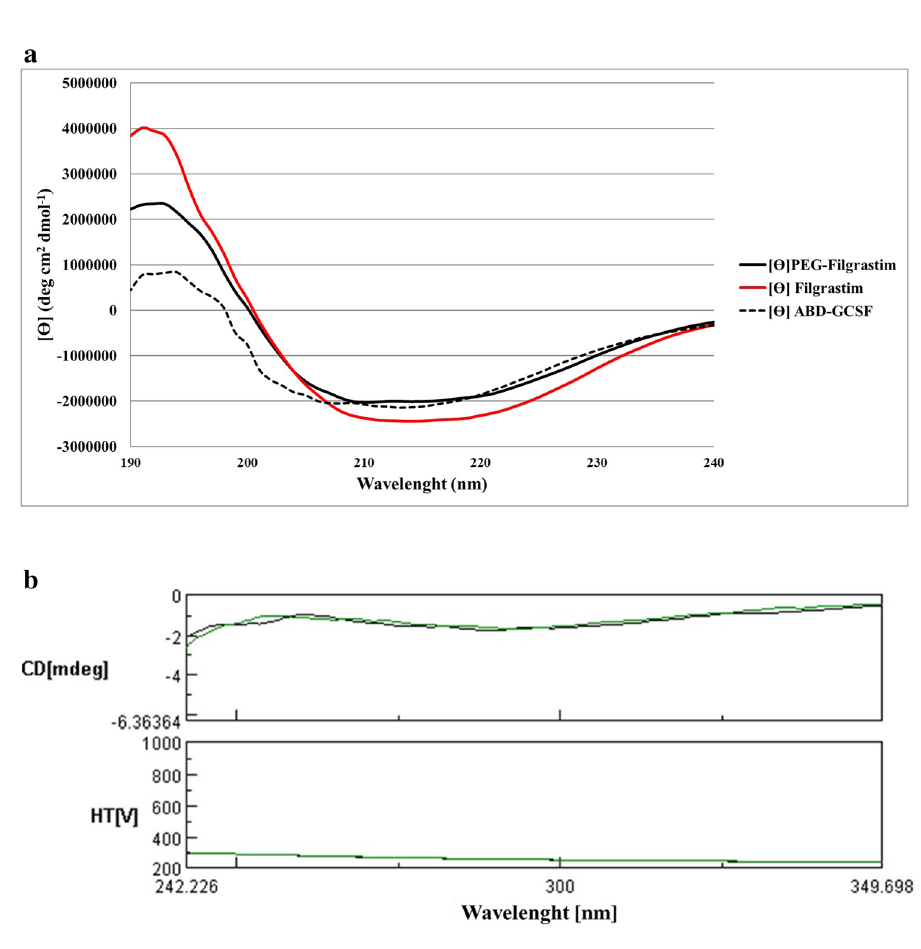
Figure 6. CD spectra of GCSF derivatives. (a) Far-UV spectrum (190–250 nm). (b) Near-UV spectrum (250–350 nm). Filgrastim and ABD-GCSF are represented in green and black lines,